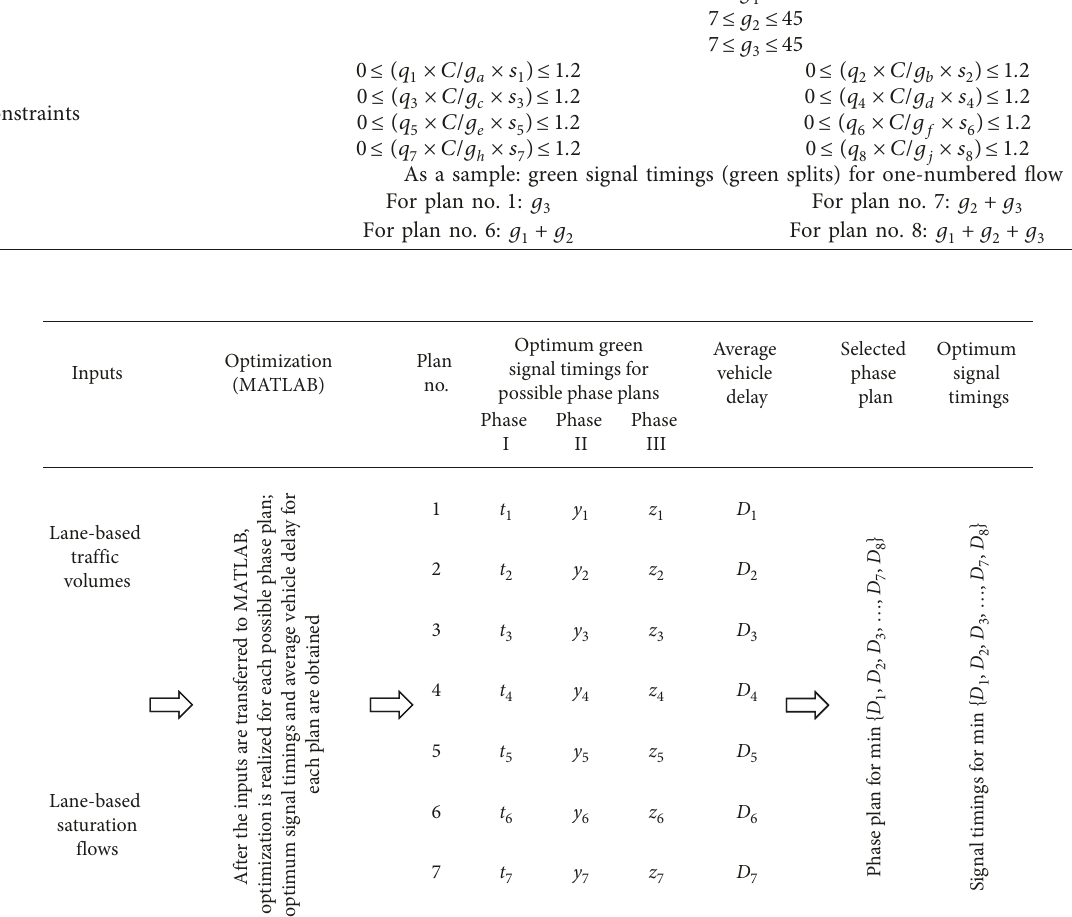
Figure 4: Selection steps of optimum signal timings and phase